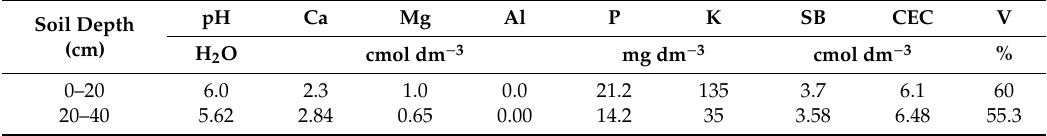
Table 1. Soil chemical characteristics of the experimental area.